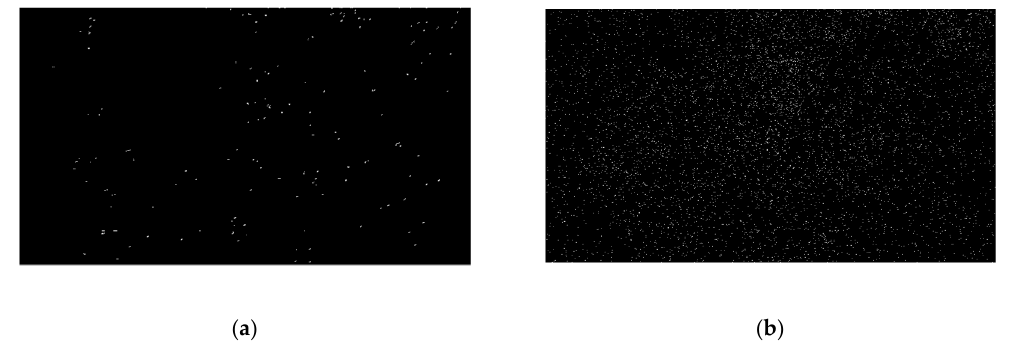
Figure 11 . Second-level binary images from sound dataset obtained by crack detection using ( a ) LoG and ( b ) Gaussian filters.